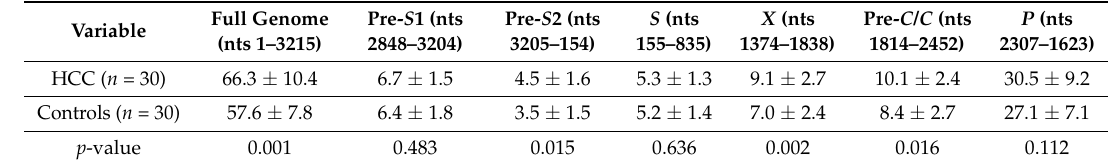
Table 1. Number of nucleotide substitutions in the full genome and various regions of the hepatitis B virus (HBV) genome in hepatocellular carcinoma (HCC) cases and